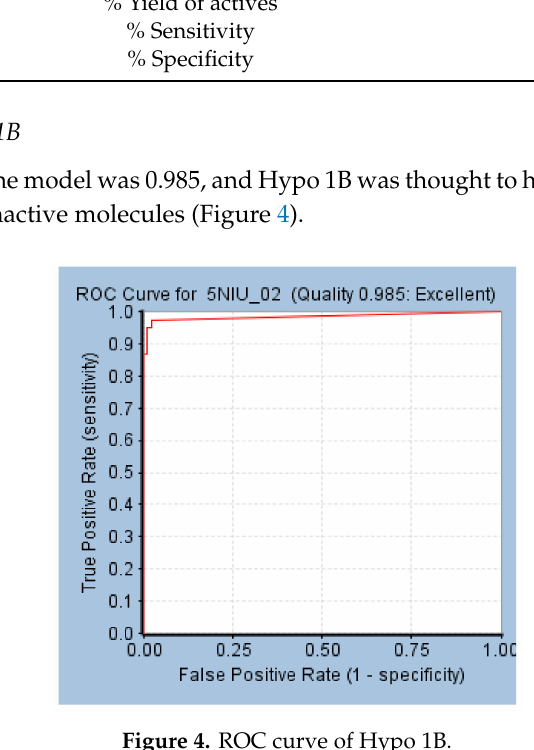
Figure 4. ROC curve of Hypo